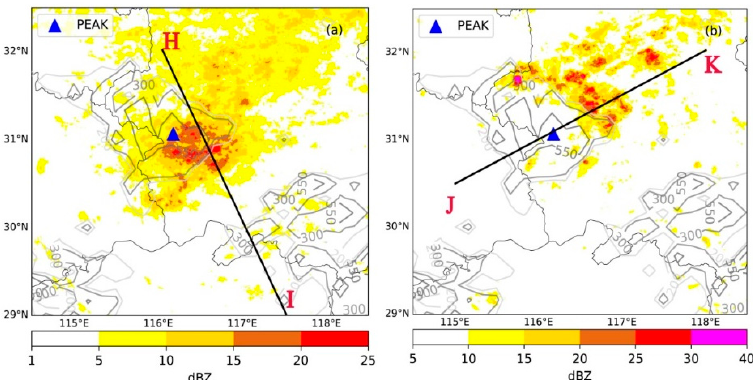
Figure 9. The spatial distribution of average composite reflectivity (shaded, unit: dBZ) of ( a ) ‘South-Type’ and ( b ) ‘North-Type’ of LCDM during the warm seasons (from April to September) of 2014–2018, in which the contours represent elevations (unit: m). The black rectangles represent high altitude of Dabie mountains. The lines ‘HI’ and ‘JK’ represent the cross-section in Figure 11.